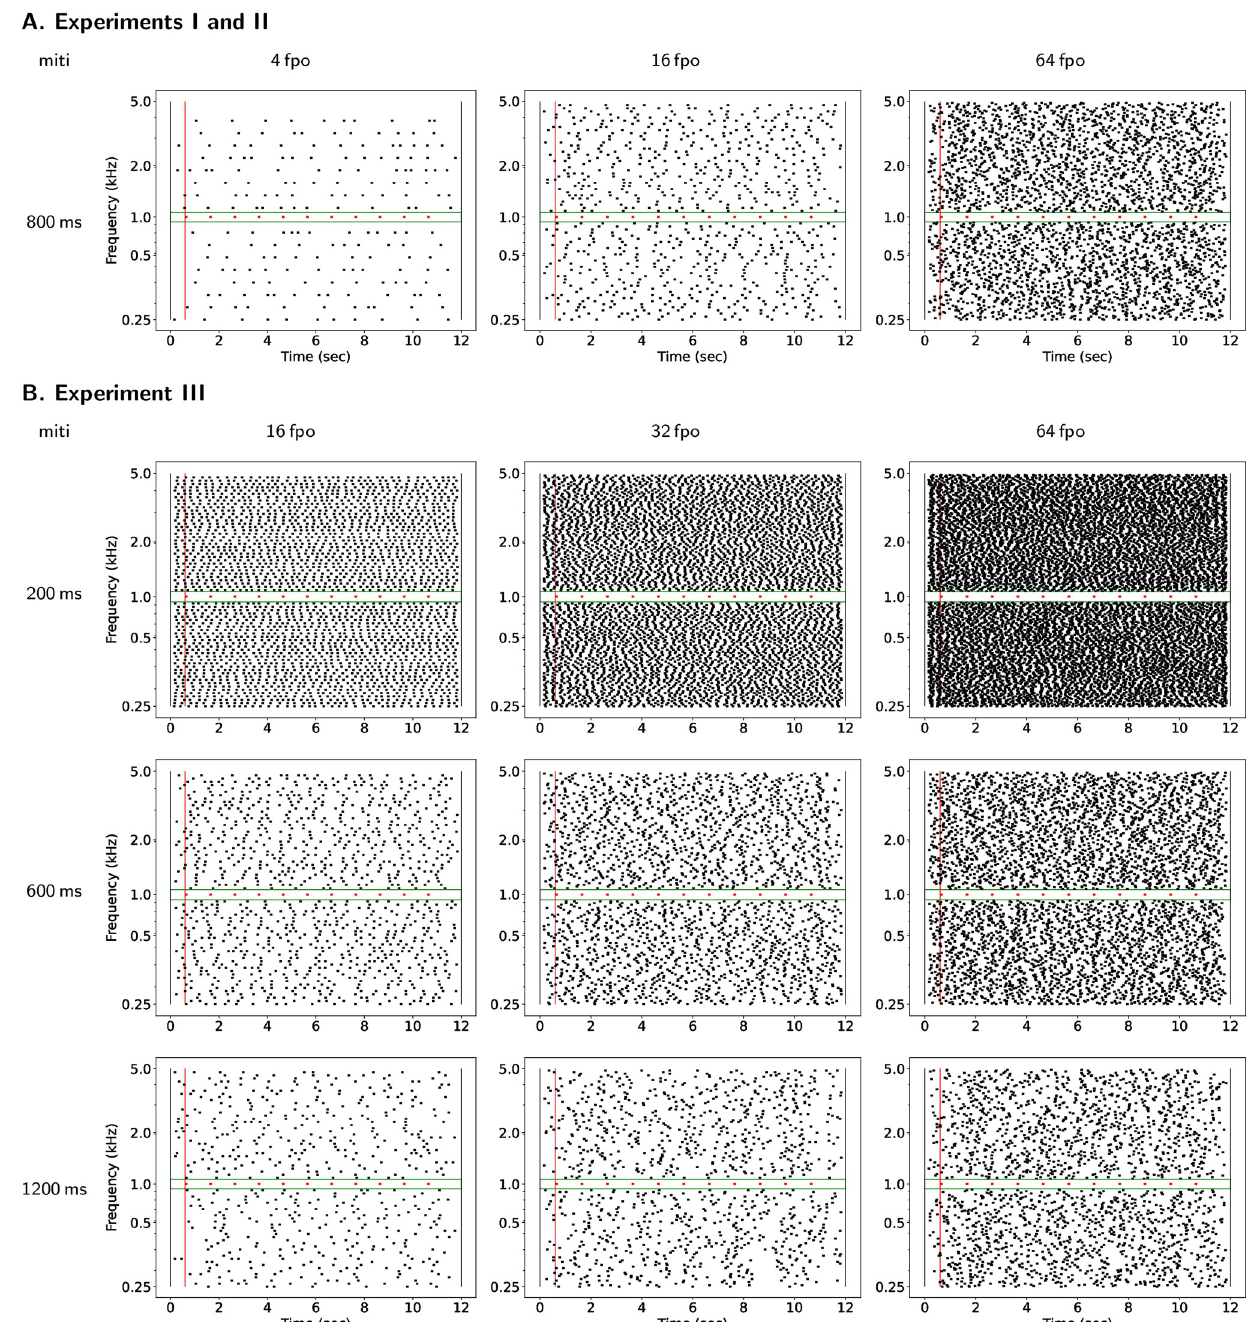
Fig 1. Graphical representations of a sample of the auditory stimuli used in the experiments. A target stream (in red) is presented in the protected region (in green) of a multi-tone masker. In the present examples, the target tones have a 1 kHz frequency, a duration of 100 ms and a repetition rate of 1 Hz. The masker tones (in black) span from 239 to 5 000 Hz and have a duration of 100 ms. Mean inter-tone interval (miti) are given on the rows and frequencies per octave (fpo) are given on the columns. (A) Experiments I and II and (B) Experiment III.